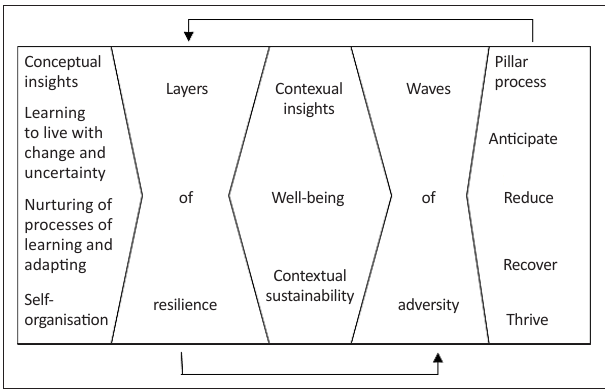
FIGURE 1: Indicators to and pillars of livelihood resilience and adaptive capacity